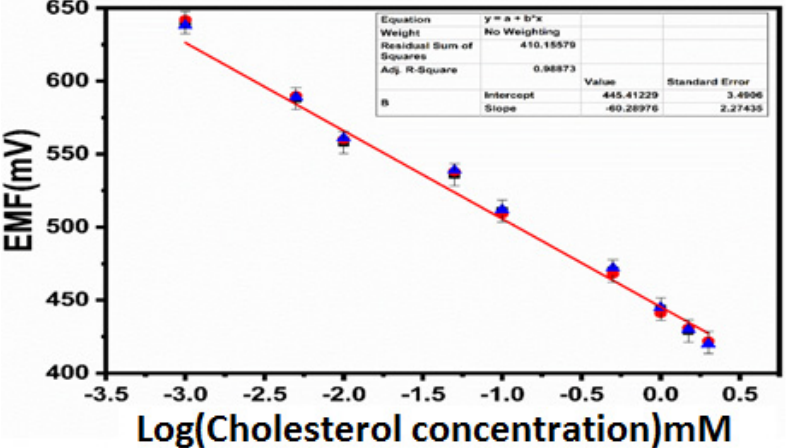
Figure 7. Repeatability study of cholesterol oxidase-immobilized Co 3 O 4 nanocrystals in 10 mM phosphate buffer solution of pH 7.3.